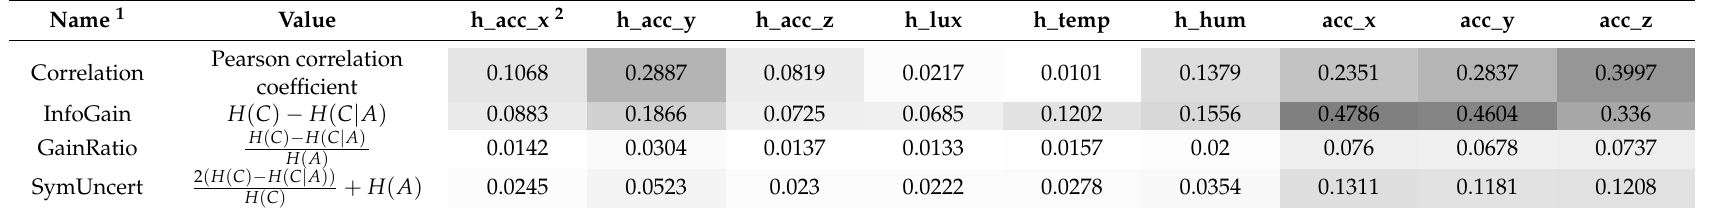
Table 1. Correlation scores of each attribute.